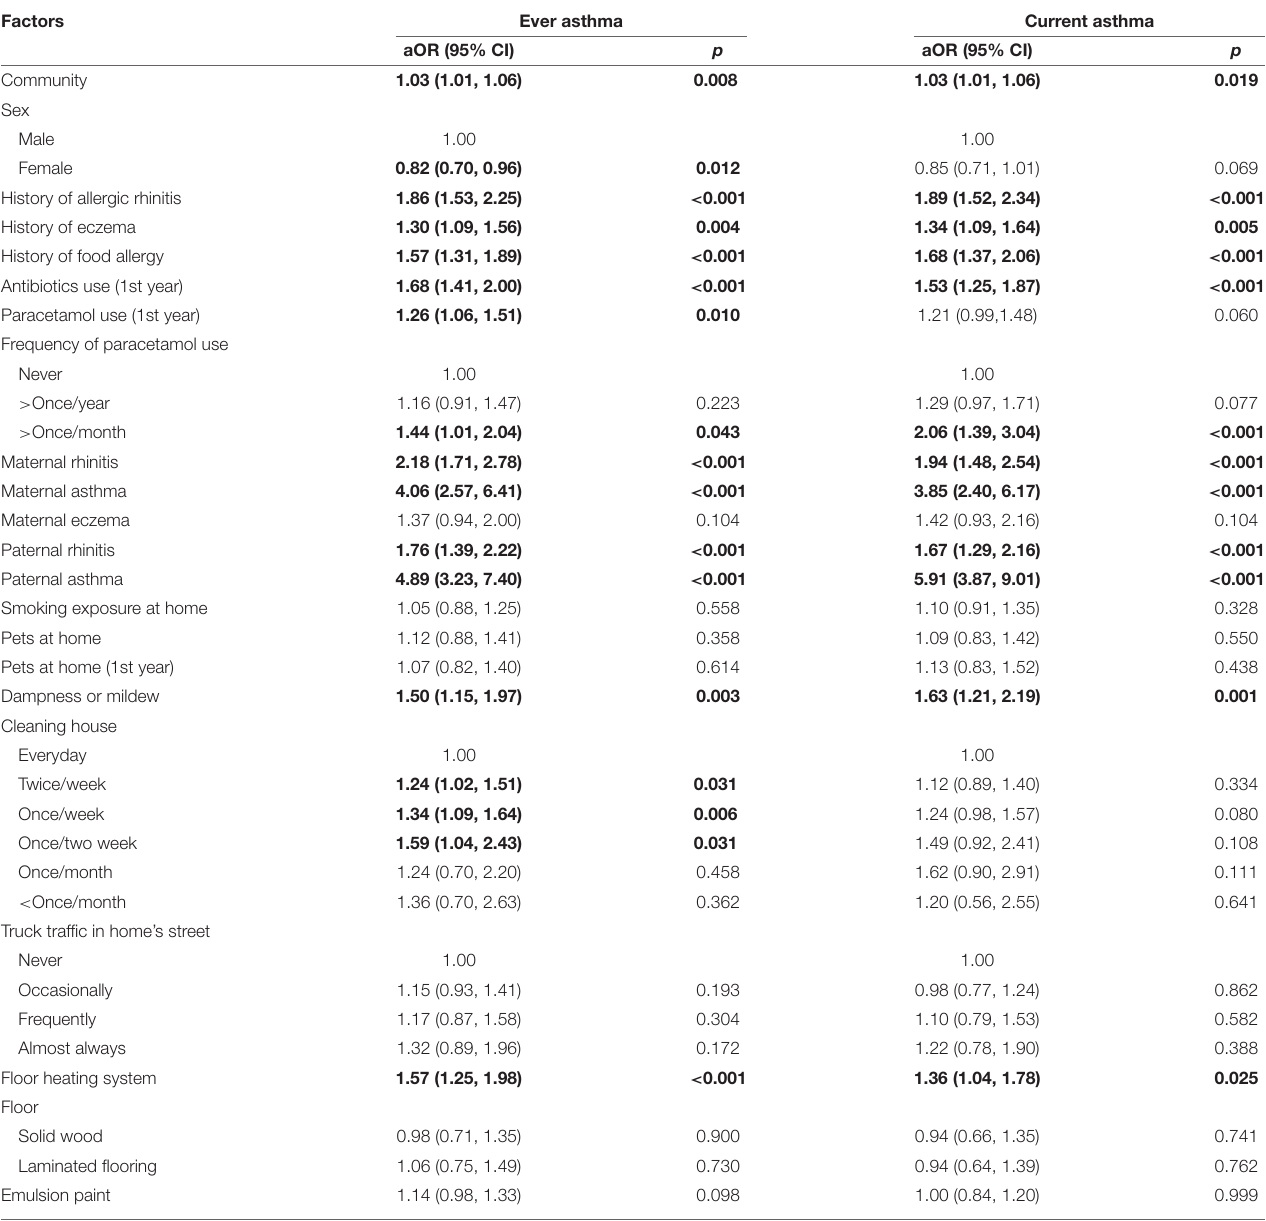
TABLE 4 | Adjusted associations between risk factors and asthma symptoms by multivariate analyses.